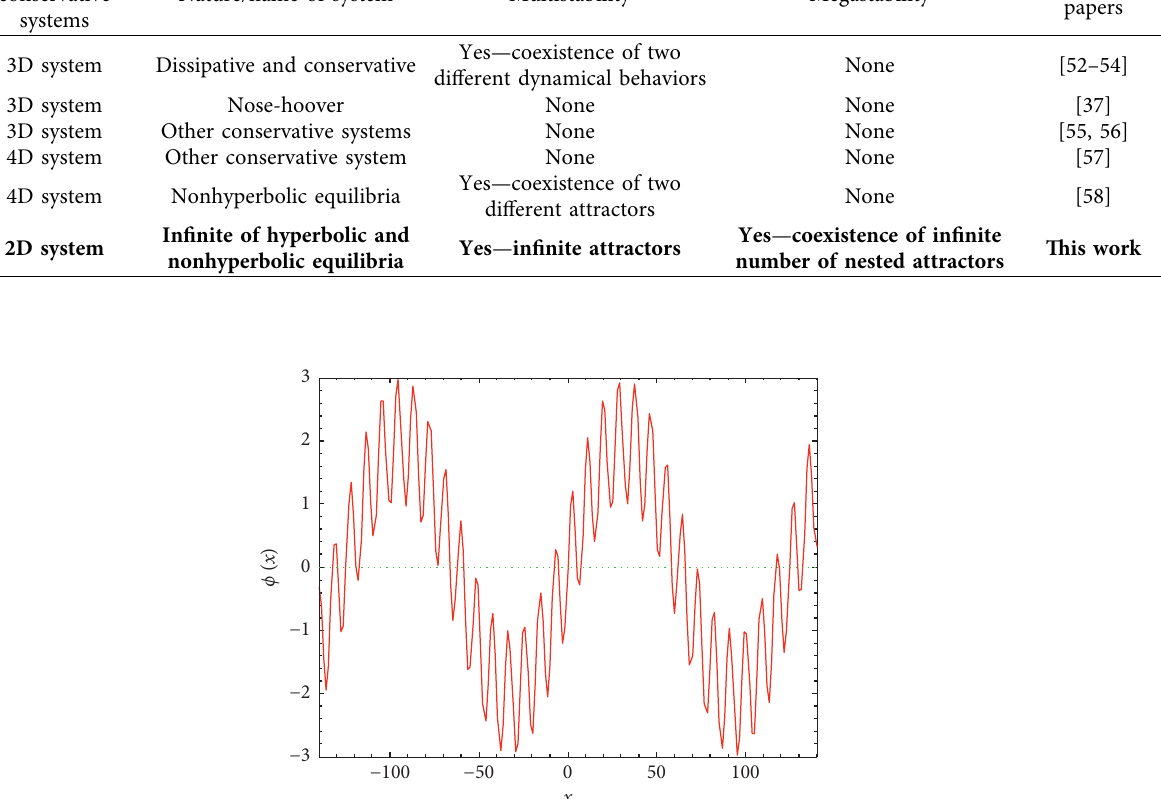
Figure 1: Graphical representation of the function ϕ ( x ) showing some views of the different fixed points of system (1) in the range x ∈ [− 140 , 140 ]